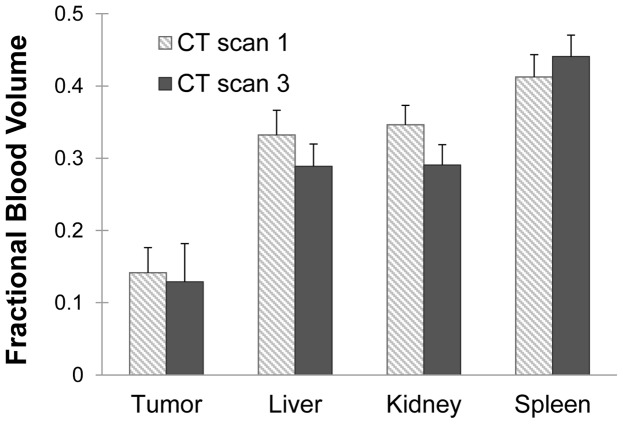
Fractional blood volume.Comparison of FBVs calculated from CT scan 1 (based on gold) and CT scan 3 (based on iodine) for each of the organs. None of the differences were found to be statistically significant (p<0.05).